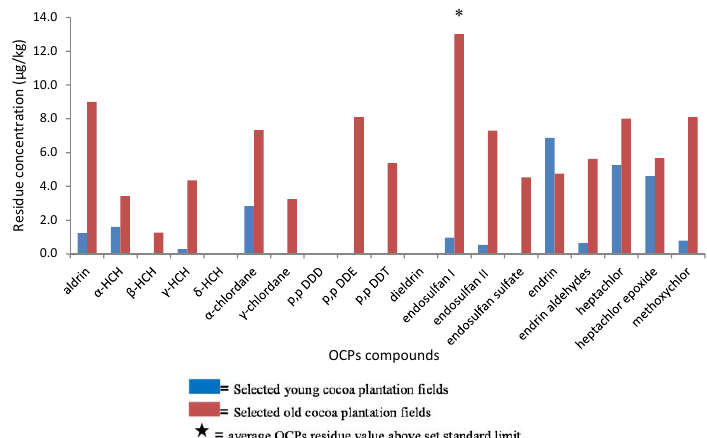
Fig. 2c : Organochlorine pesticides residue profile level in cocoa plantation soil of Ekiti State.